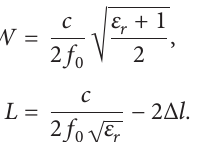
Figure 2: Input impedance of the proposed